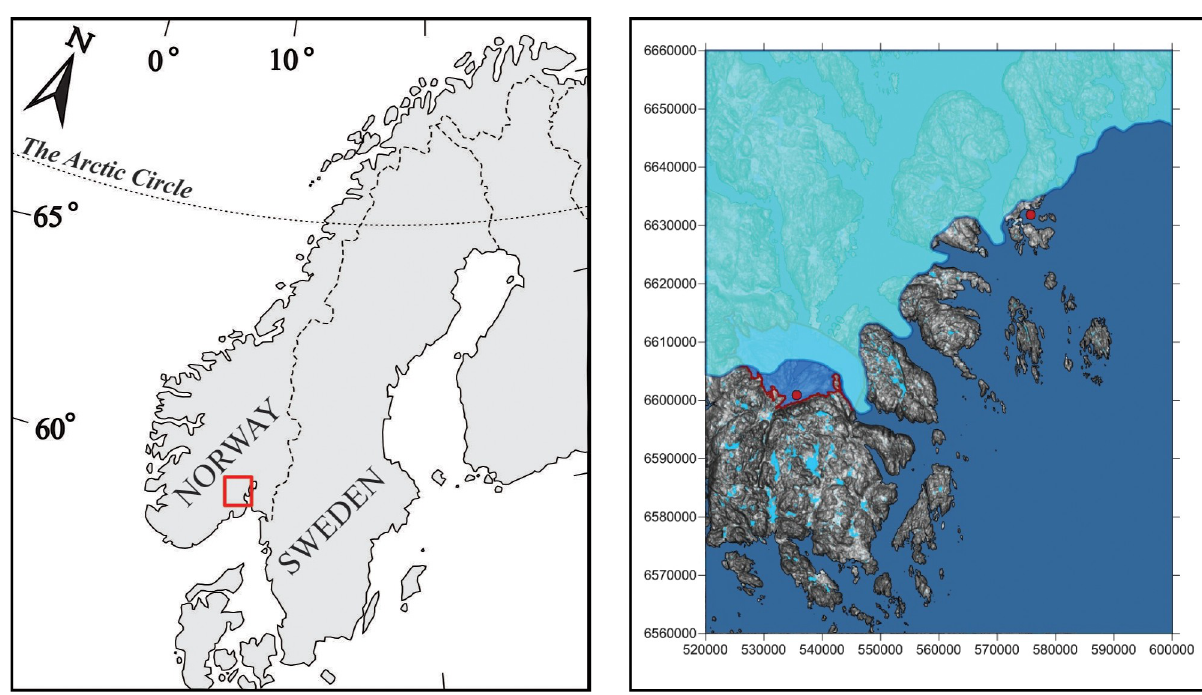
Fig 1. Study area and the estimated pro-glacial lake location. Left panel; map of Norway and study area. Right panel; the modelled position of the pro-glacial lake covering the Sand å grotta cave and Lake Lille Lauarvann (both situated in the red dot in lower part of figure). The geographically distant Lake Ulvenvann population is the other red dot in the upper part of figure. At this time, Lake Ulvenvann was not yet